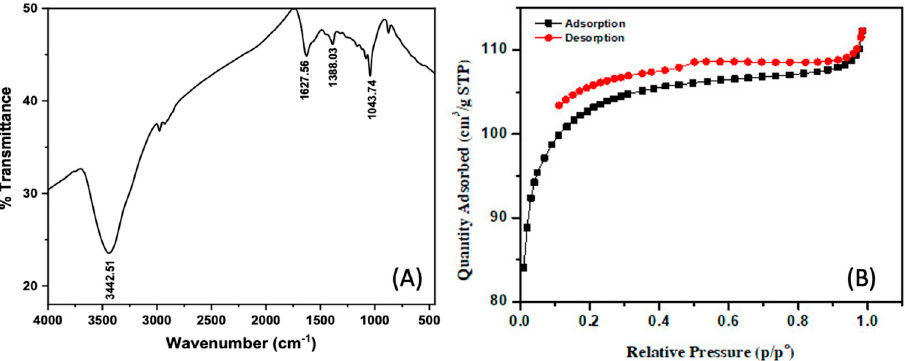
Figure 4. FT − IR infrared spectrum ( A ) and Nitrogen adsorption − desorption isotherms ( B ) of ACDS.